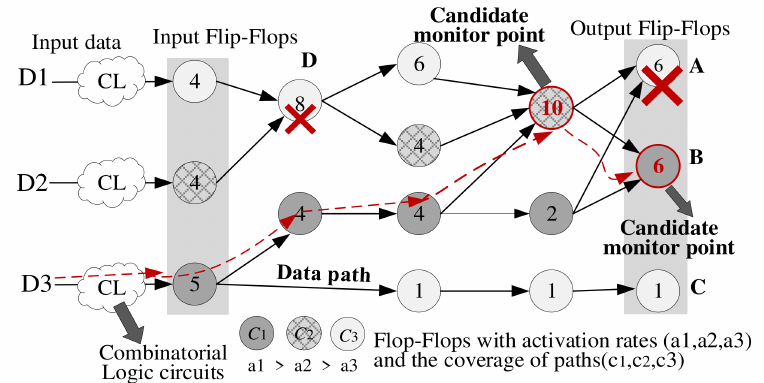
Figure 8. Illustration of the MAHS sifting monitor